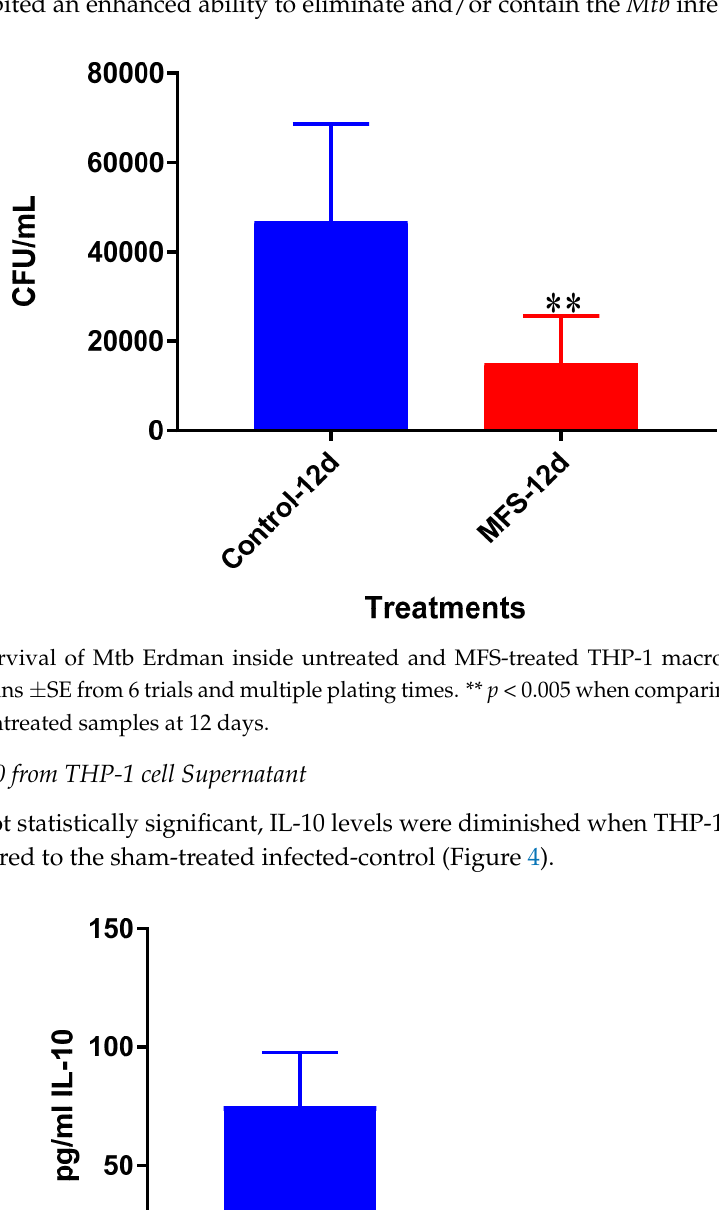
Figure 2. Hematoxylin and Eosin staining of untreated and MFS-treated samples of THP-1 cells. Microscopy work was done under 100×. 2.3. Intracellular Survival of Mtb Erdman from THP-1 Cells The bacterial quantity of Mtb Erdman was approximately 2.5 times lower when THP-1 cells were treated with MFS versus no treatment after 12 days (Figure 3). These data indicate that MFS treated THP-1 cells exhibited an enhanced ability to eliminate and/or contain the Mtb infection.